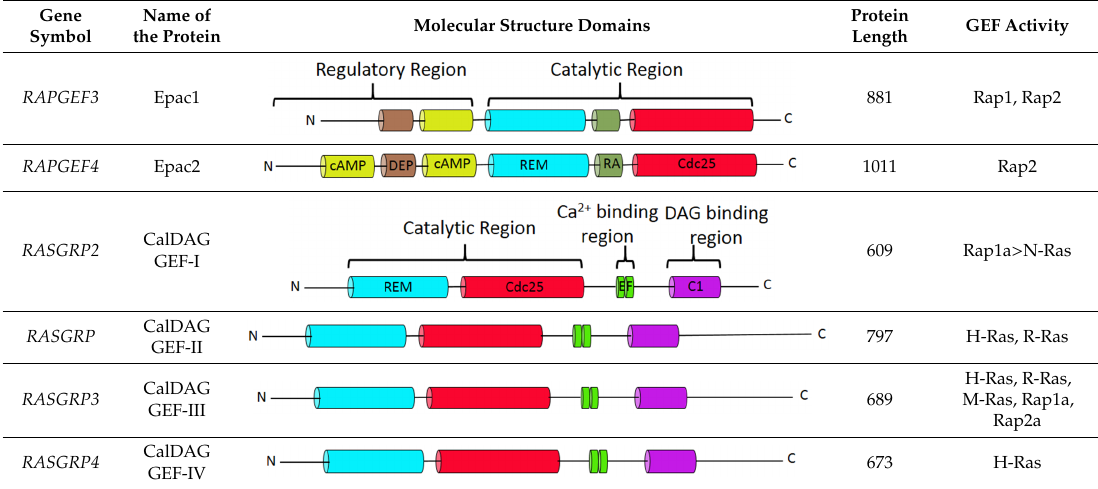
Table 1. Domain structure and specificity of Rap1 regulatory proteins.